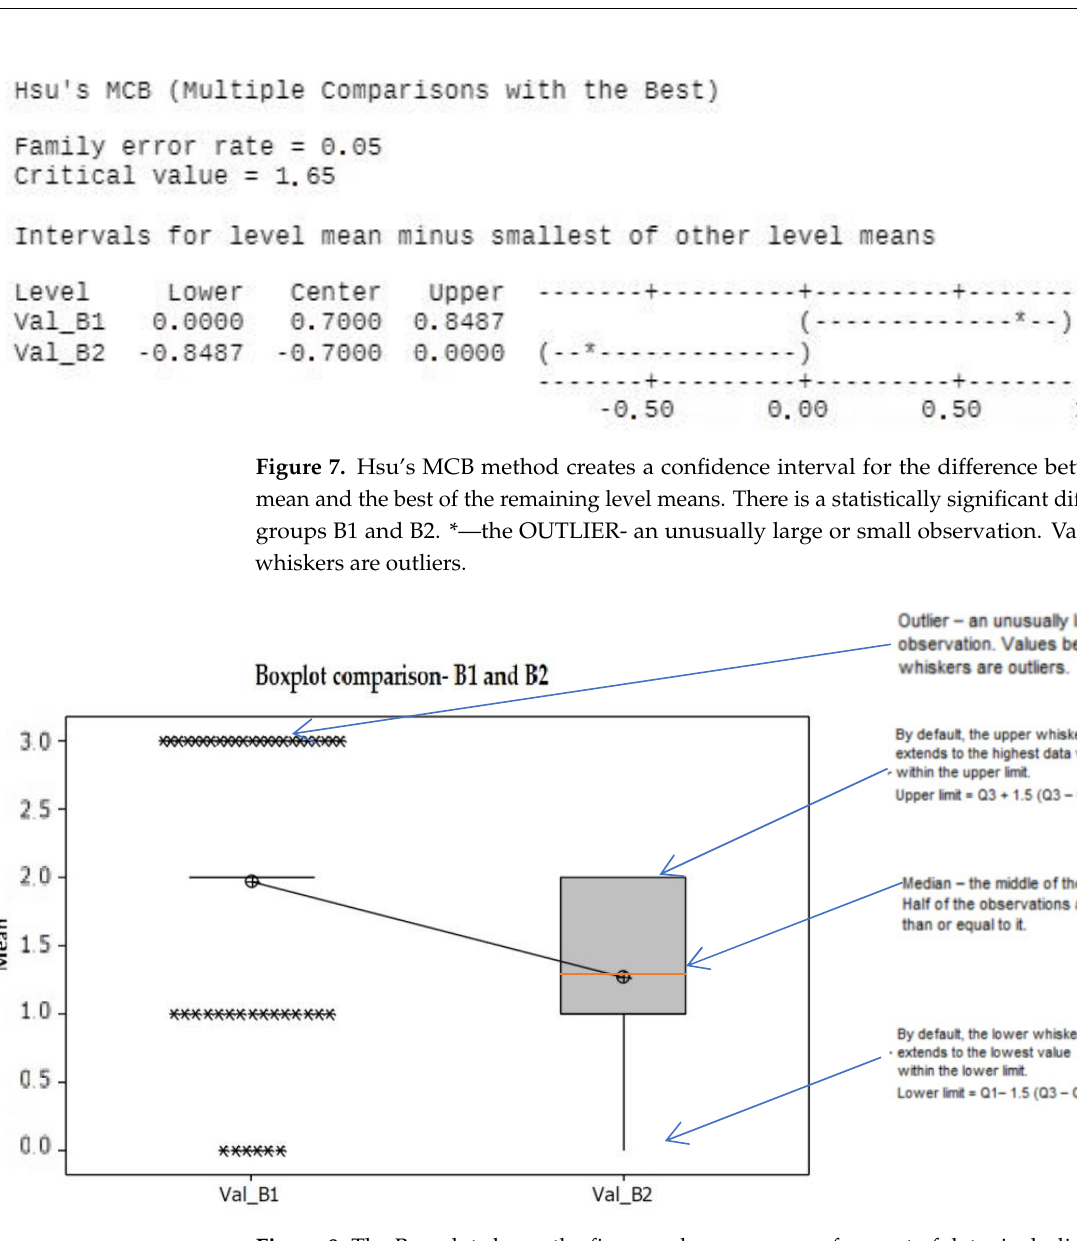
Figure 8. The Box plot shows the five-number summary of our set of data: including the minimum score, first (lower) quartile, median, third (upper) quartile, and maximum score. The box for B1 is actually a line (quarta Q1 and Q3 = 2 overlap). There are significant differences.The median is the red line through the middle of the ‘box’. We can see that this is just above the number 60 on the number line below. So the middle value of age is 60 years. The upper side of the box is the 1st quartile. This is the value that separates the first quarter, or 25% of the data, from the rest. The lower side of the box is the 3rd quartile. This is the value that separates the first three quarters, or 75% of the data, from the rest. The distance between the sides of the box is called the inter-quartile range (IQR). This tells us where the ‘middle half’ of the values are. The ends of the lines from the box at the left and the right are the minimum and maximum values in the data. The distance between these is called the range.